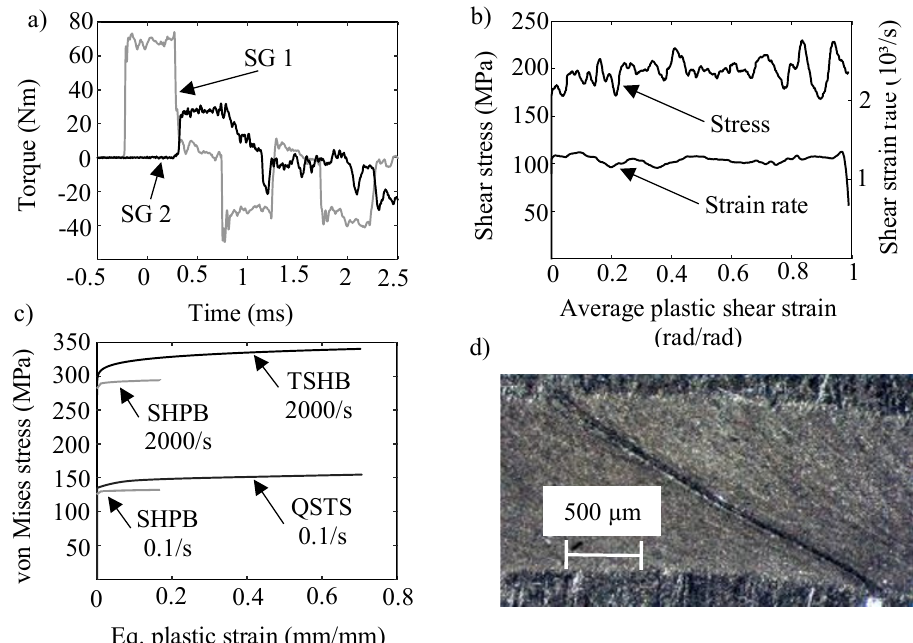
Figure 7 : Typical test data: (a) Raw signals measured by strain gauges for TSHB test, (b) Shear stress and shear strain rate against strain for TSHB test, (c) Comparison of QSTS and TSHB test data with known literature [10], and (d) Microscope image of deformed specimen associated with a QSTS